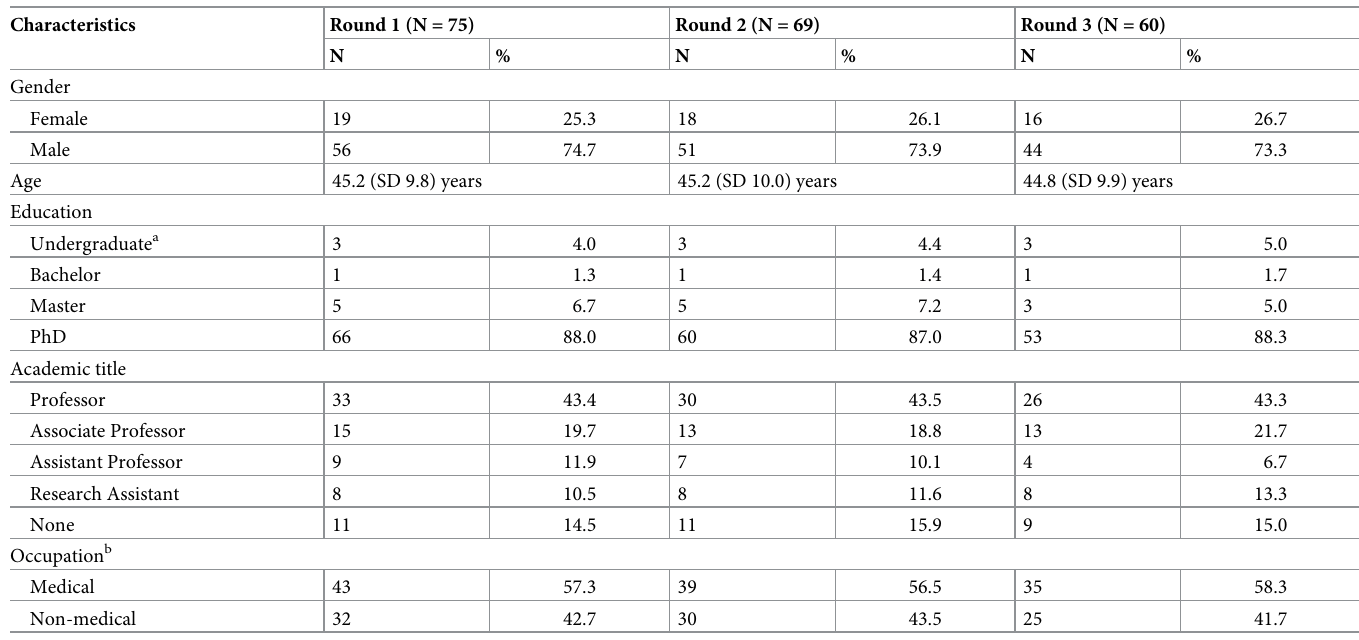
Table 1. Demographic characteristics of participants in Delphi